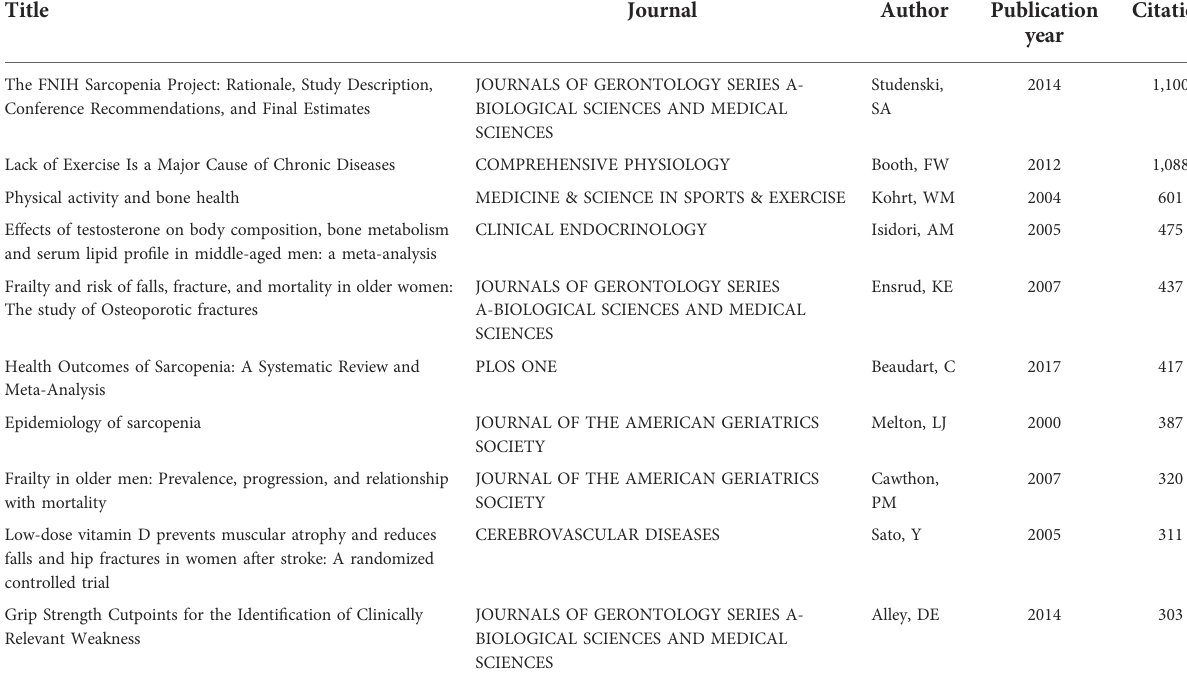
TABLE 2 The general information of the top 10 studies with the most